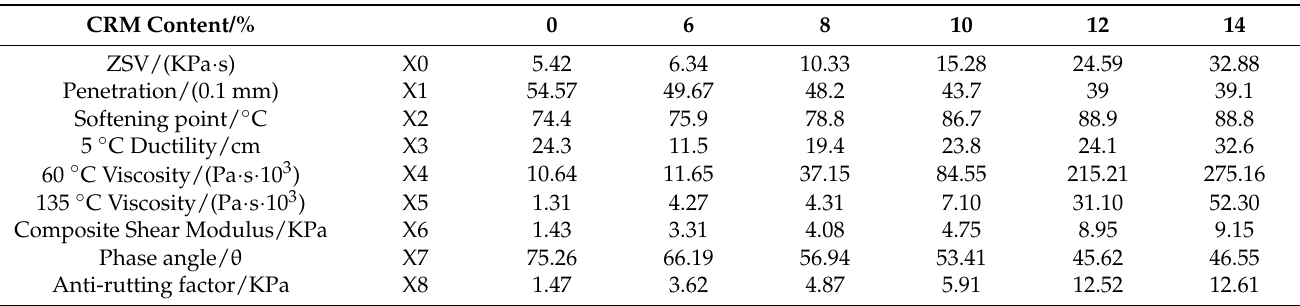
Table 7. Gray correlation analysis of ZSV and the other properties for the hybrid modified asphalt binders with Shell base